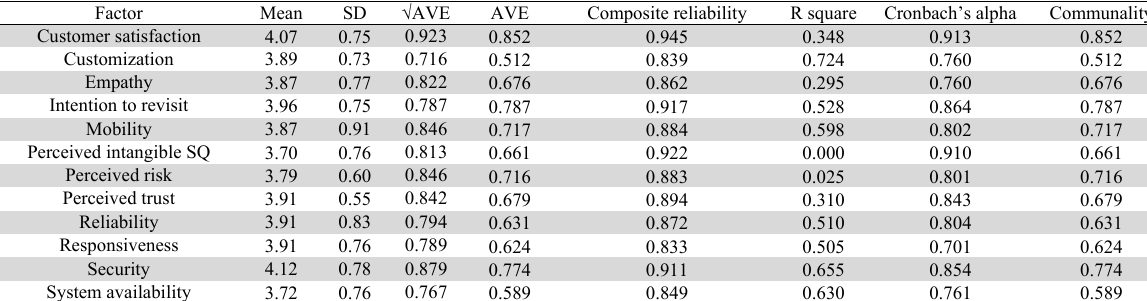
The summary of some basic statistics